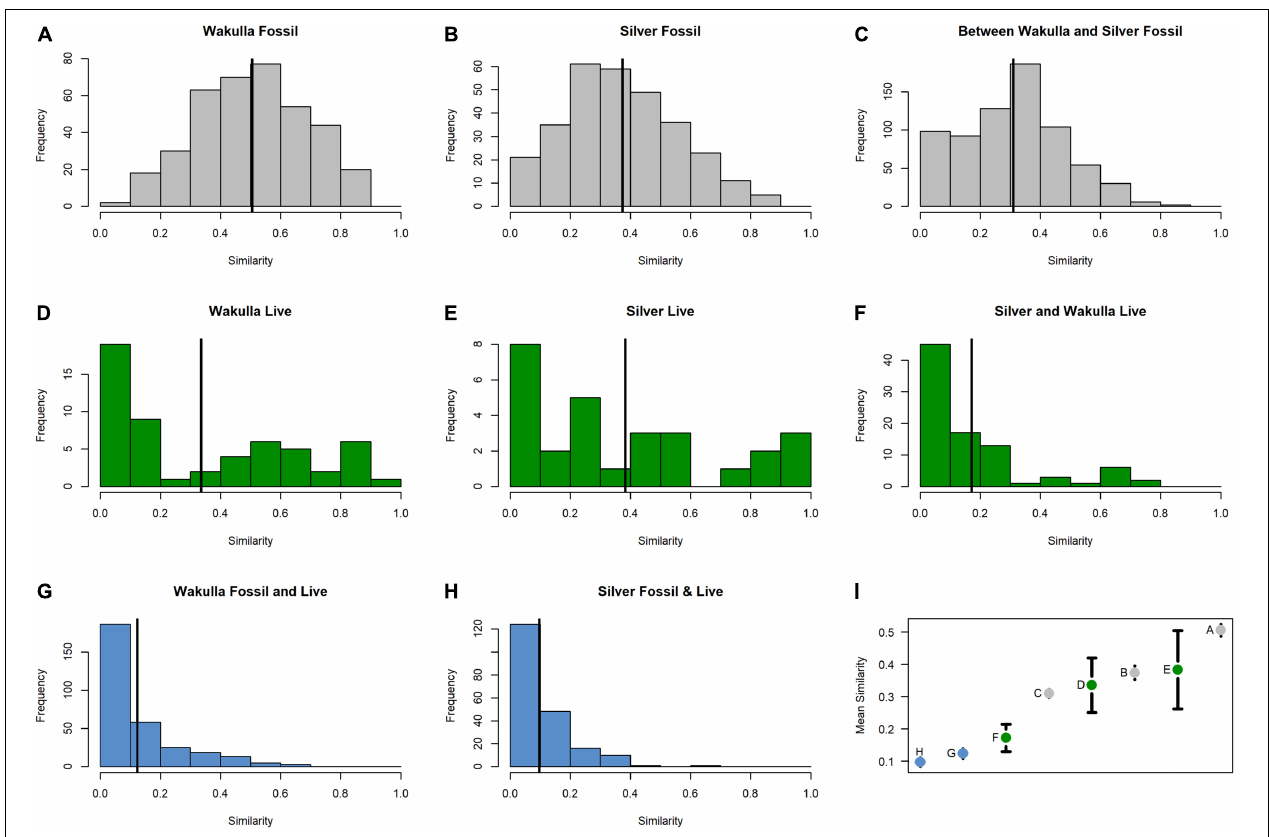
FIGURE 2 | Pairwise comparisons of Bray-Curtis similarities between fossil (gray) samples (A) within the Wakulla River, (B) within the Silver and Ocklawaha Rivers, (C) between the Wakulla, Silver, and Ocklawaha Rivers, between live (green) samples (D) within the Wakulla River, (E) within the Silver and Ocklawaha Rivers, (F) between the Wakulla, Silver, and Ocklawaha Rivers, and between fossil and live (blue) samples (G) within the Wakulla River and (H) within the Silver River. (I) Mean similarities of the eight pairwise comparisons with 95% confidence intervals. (A–H) represent their respective panels in Figure 2 . TABLE 3 | Probability of observed mean pairwise similarity between sample sets evaluated using randomly generated null model of no difference in means. Comparison p